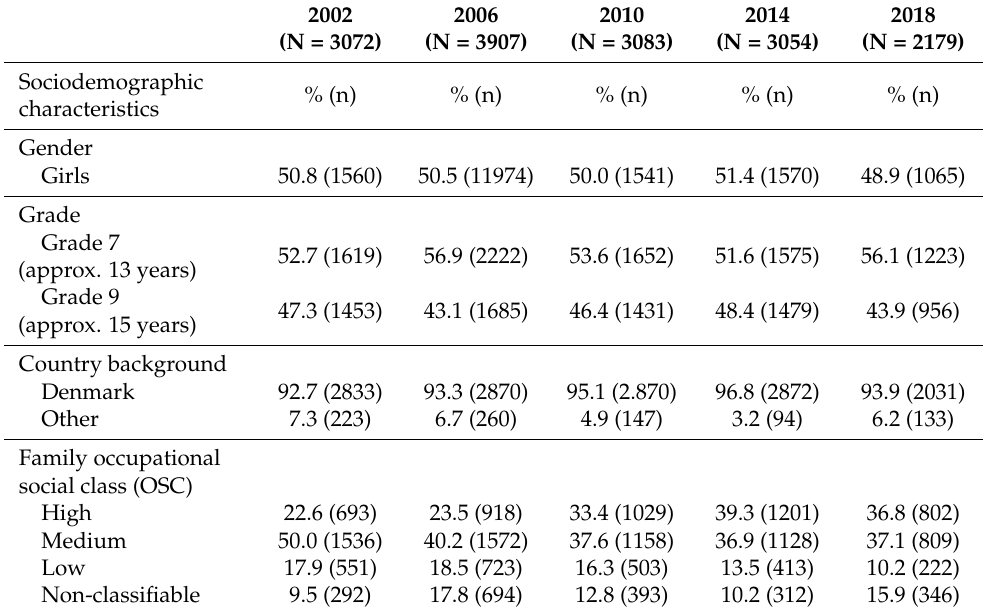
Table 1. Characteristics of the study population at five time points,